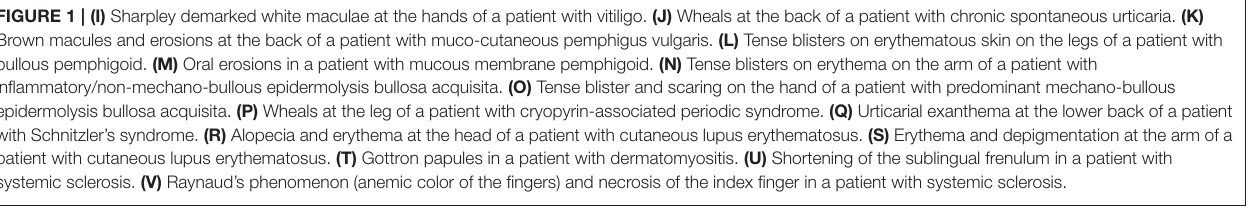
FIGURE 1 | (I) Sharpley demarked white maculae at the hands of a patient with vitiligo. (J) Wheals at the back of a patient with chronic spontaneous urticaria. (K) Brown macules and erosions at the back of a patient with muco-cutaneous pemphigus vulgaris. (L) Tense blisters on erythematous skin on the legs of a patient with bullous pemphigoid. (M) Oral erosions in a patient with mucous membrane pemphigoid. (N) Tense blisters on erythema on the arm of a patient with inflammatory/non-mechano-bullous epidermolysis bullosa acquisita. (O) Tense blister and scaring on the hand of a patient with predominant mechano-bullous epidermolysis bullosa acquisita. (P) Wheals at the leg of a patient with cryopyrin-associated periodic syndrome. (Q) Urticarial exanthema at the lower back of a patient with Schnitzler’s syndrome. (R) Alopecia and erythema at the head of a patient with cutaneous lupus erythematosus. (S) Erythema and depigmentation at the arm of a patient with cutaneous lupus erythematosus. (T) Gottron papules in a patient with dermatomyositis. (U) Shortening of the sublingual frenulum in a patient with systemic sclerosis. (V) Raynaud’s phenomenon (anemic color of the fingers) and necrosis of the index finger in a patient with systemic